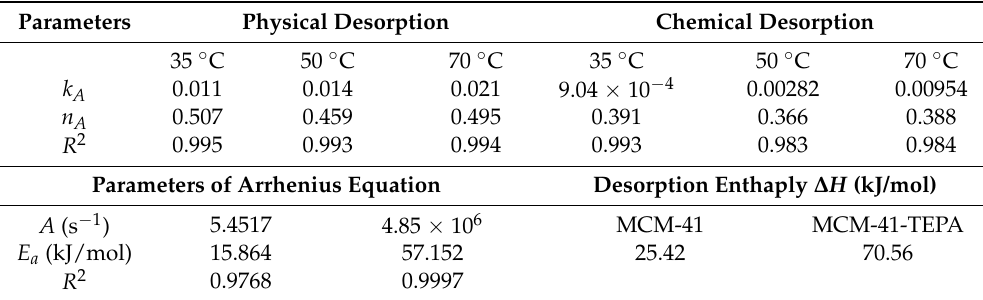
Figure 3. Arrhenius plots for the kinetic parameters. Table 2. Kinetic parameters for TEPA-based MCM-41 at different temperatures and calculated from CO 2 desorption isotherms fitted to the Arrhenius equation.